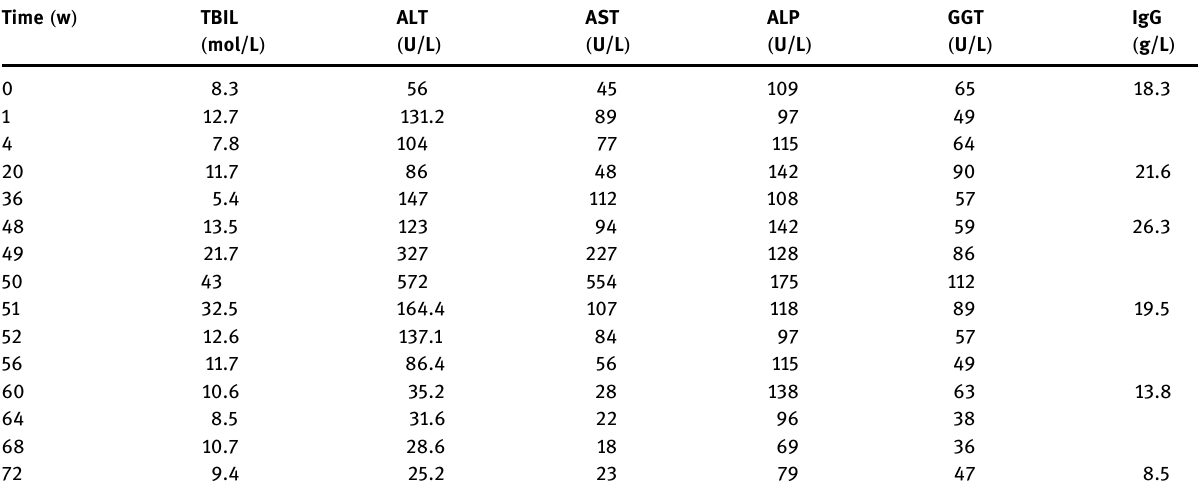
Table A1: Changes of main indexes of liver function and immunoglobulin